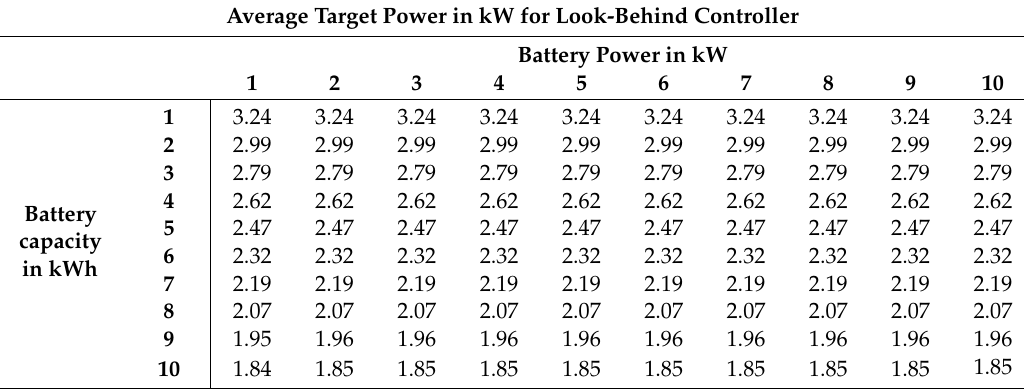
Table A2. Average target power in kW for look-behind controller.